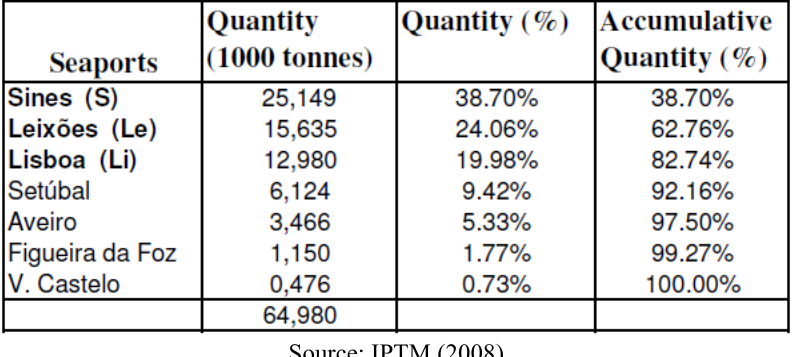
Figure 3: Total traffic in the main Portuguese seaports in 2008